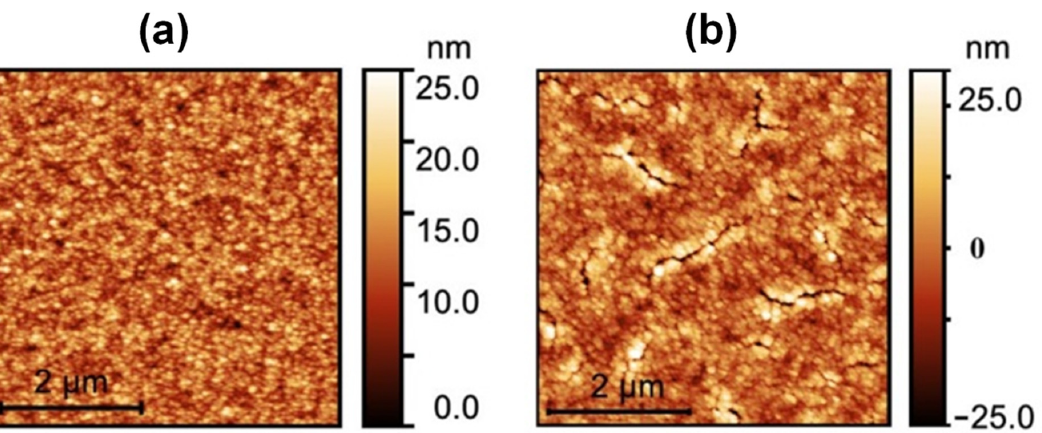
Figure 11. AFM image of a 210 nm thick (AR 1  ) film before (a) and after (b) 17 h of ammonia curing.